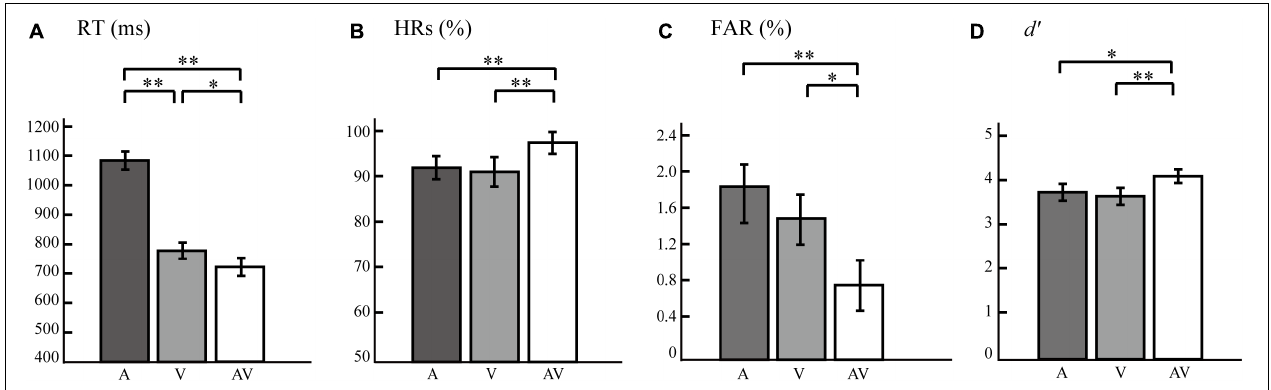
FIGURE 2 | Bar plots showing behavioral results. (A) Mean response times (RTs) for A, V, and AV target stimuli. (B) Mean hit rates (HRs) for A, V, and AV target stimuli. (C) False alarm rates (FARs) for A, V, and AV target stimuli. (D) Perception sensitivity ( d (cid:48) ) for A, V, and AV target stimuli. The error bars represent the SEM. SEM, standard error of mean. ∗∗ p < 0.01, ∗ p <